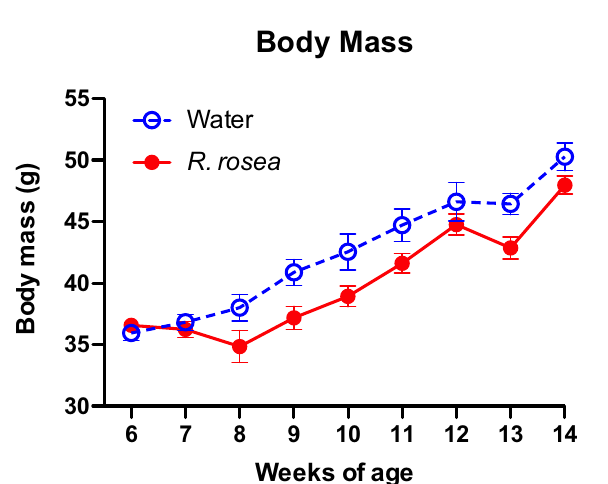
Figure 4. Altered insulin tolerance in Rhodiola rosea -treated db/db mice. Insulin tolerance test (ITT) of db/ db mice. ITT was conducted at 11 weeks of age. Following a 4 h fast, mice were injected intraperitoneally with 0.75 IU/kg insulin. Blood was sampled pre-injection and at 30, 60 and 120 minues post-injection and glucose levels determined. The difference between the two data sets is significant ( P < 0.05, one-way repeated measures ANOVA; n = 7 for water and n = 11 for R. rosea -treated).